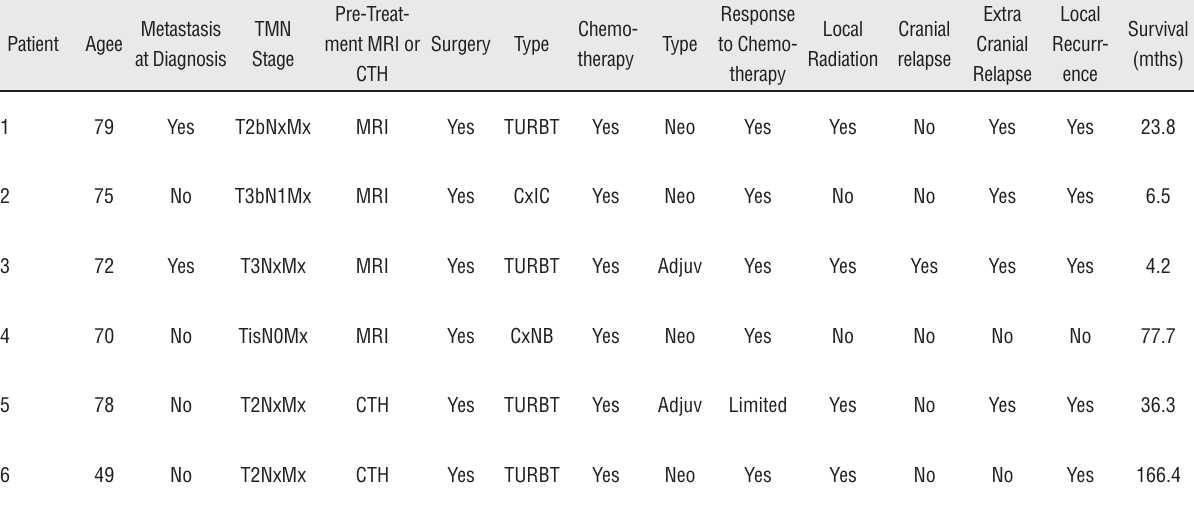
Table 3 - Disease details and outcomes of patients treated with prophylactic cranial irradiation. Pre-Treat- Metastasis TMN Patient Agee ment MRI at Diagnosis Stage